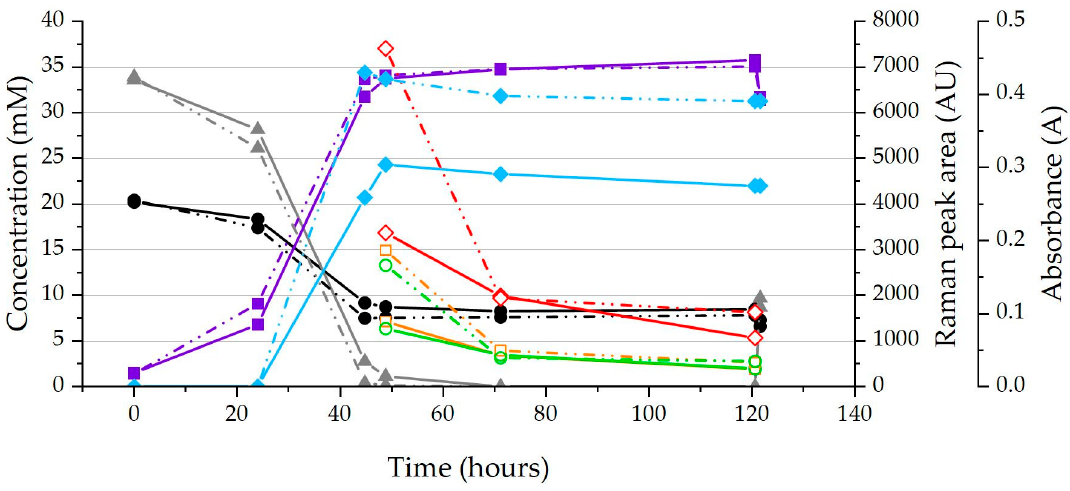
Figure 2. Raman peak areas (Raman peak areas: 1314 cm − 1 ○ , 1130 cm − 1 □ , 749 cm − 1 ◇ ), metabolite concentrations (Fumarate ▲ , Succinate ■ and Acetate ● ) and OD600 (Absorbance ◆ ) of Δ pilA and KN400 (KN400 is shown with a solid line and Δ pilA with dotted line) of an example run showing the significant difference between maximum Raman peak areas of the strains, as well as the significant decrease as stationary phase is reached.